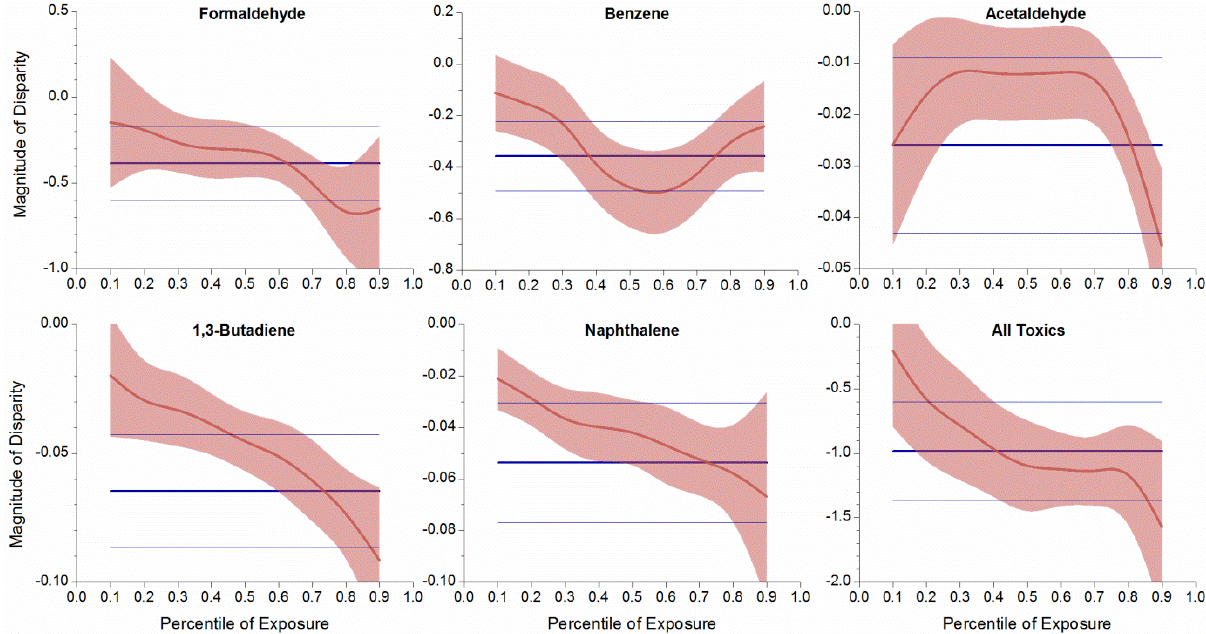
Figure 5. Uneven magnitude of socioeconomic disparity over exposure